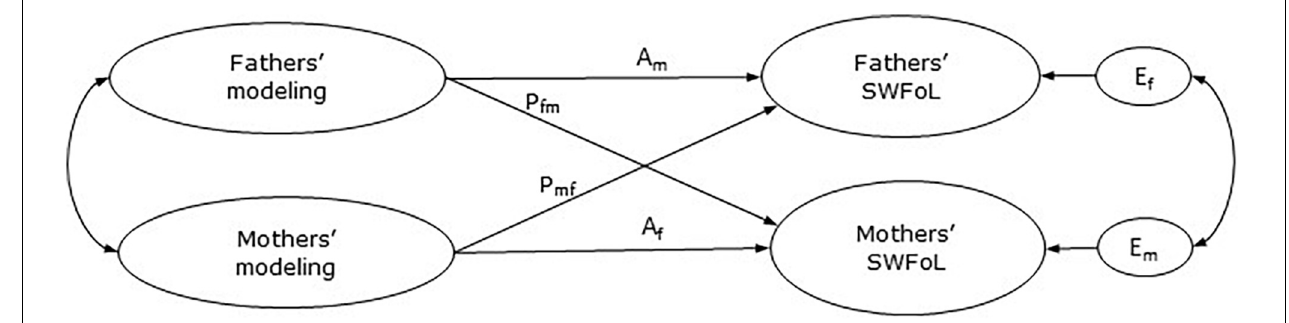
FIGURE 1 | Basic actor-partner interdependence model of modeling and satisfaction with food-related life (SWFoL). A m , actor effect of father’s modeling on his own SWFoL; A f , actor effect of mother’s modeling on her own SWFoL; P fm , partner effect of father’s modeling on mother’s SWFoL; P mf , partner effect of mothers’ modeling on fathers’ SWFoL; E f and E m , residual errors on SWFoL for the father and mother, respectively.